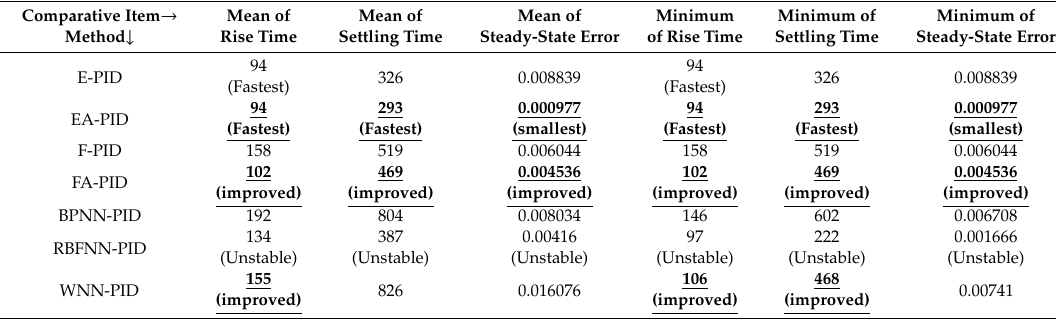
Table 9. Comparison of di ff erent intelligent control